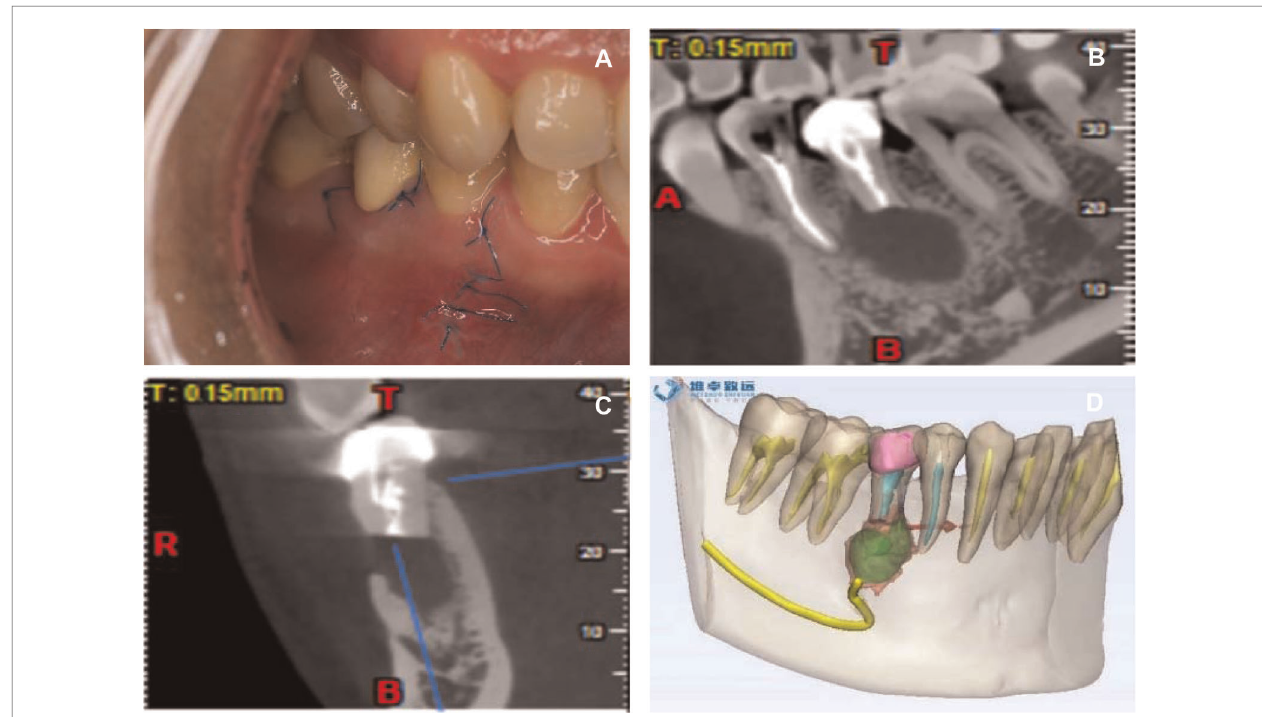
FIGURE 5 | The CBCT images were reviewed. ( A ) One week postoperative wound condition ( B ) Complete resection of apical lesions ( C ) Distance from the inferior alveolar nerve canal in the lesion area after surgical resection ( D ) Resection range covers the extent of the lesion.